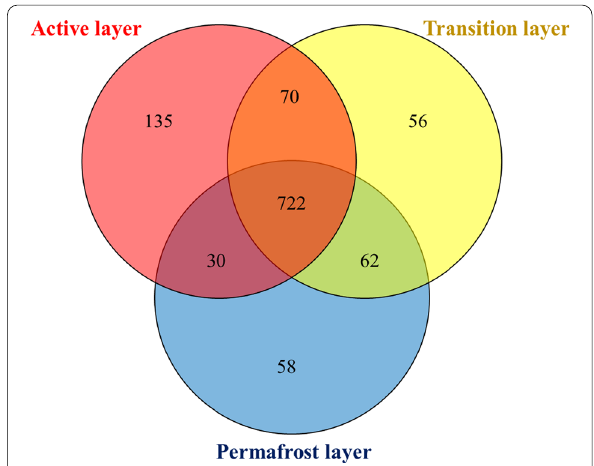
Fig. 3 Venn diagram showing the number of unique and overlapping genera between different soil